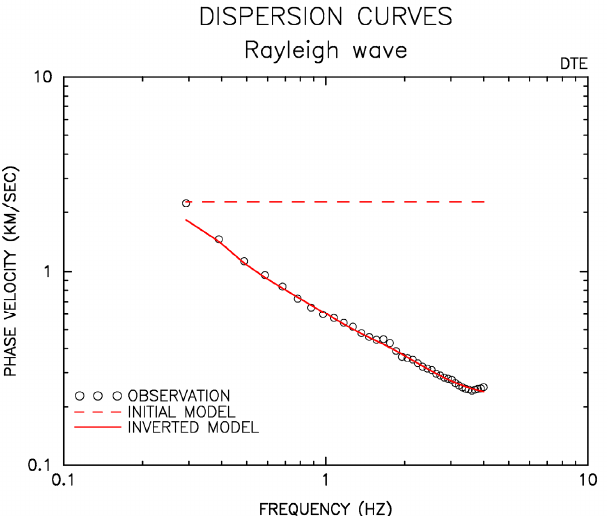
Figure 9. Observed (open circles) and theoretical (red line) phase velocities for the inverted S-wave velocity structures at site DTE. The phase velocities for the initial and inverted S-wave velocity structures are shown in red dashed lines and red solid lines, respectively.